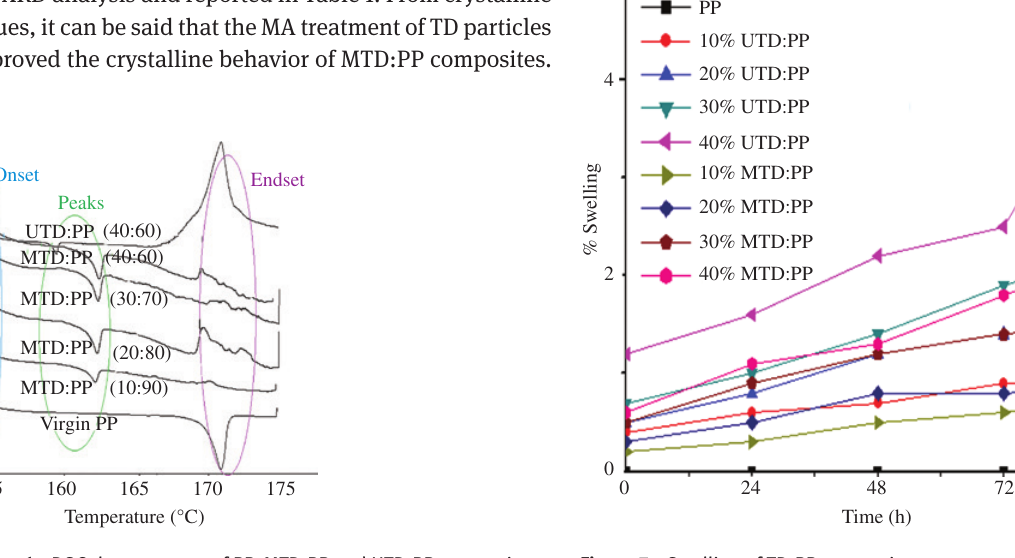
Figure 6: DSC thermograms of PP, MTD:PP and UTD:PP composites. Figure 7: Swelling of TD:PP